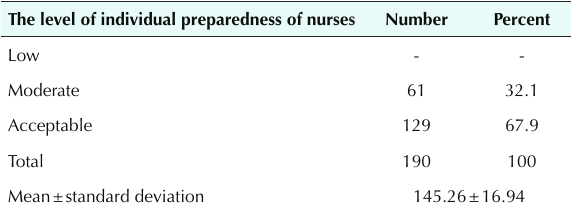
Table 3. Frequency distribution of individual preparedness of emergency nurses The level of individual preparedness of